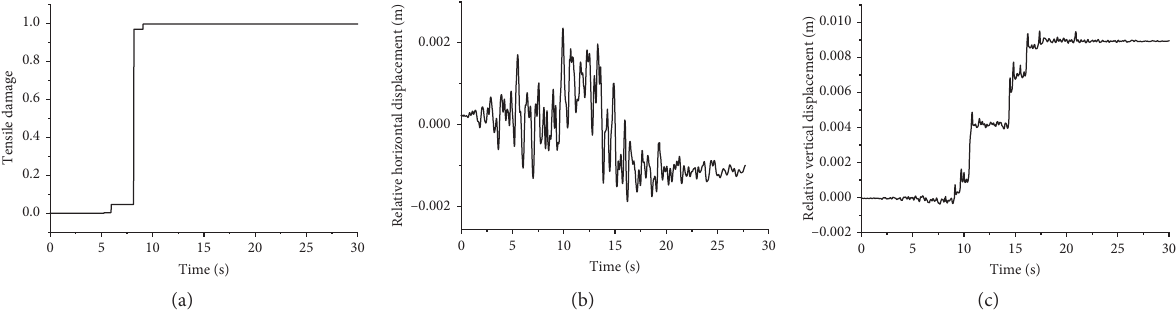
Figure 14: Time histories of relevant variables at the element 3401 for the earthquake overload coefficient of 2.0. (a) Time history of tensile damage variables. (b) The relative horizontal displacement is 0.95mm after the earthquake. (c) The relative vertical displacement is 8.95mm after the